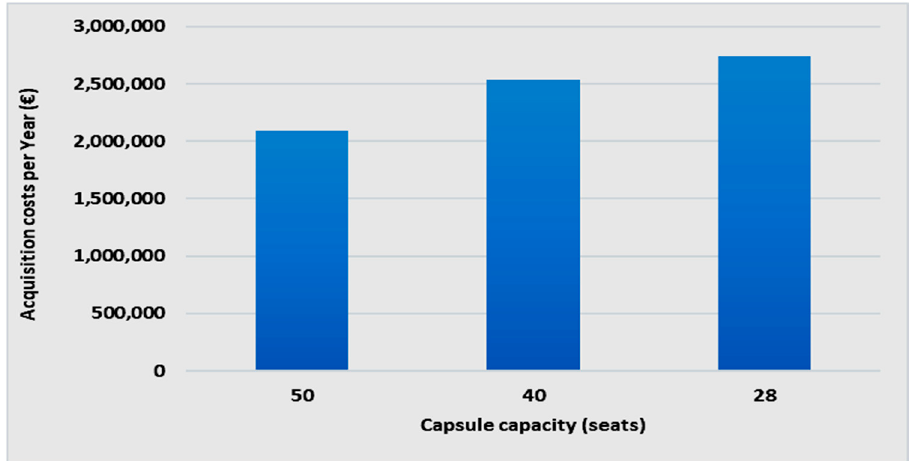
Figure 6. Acquisition costs per year under alternative capsule capacities.